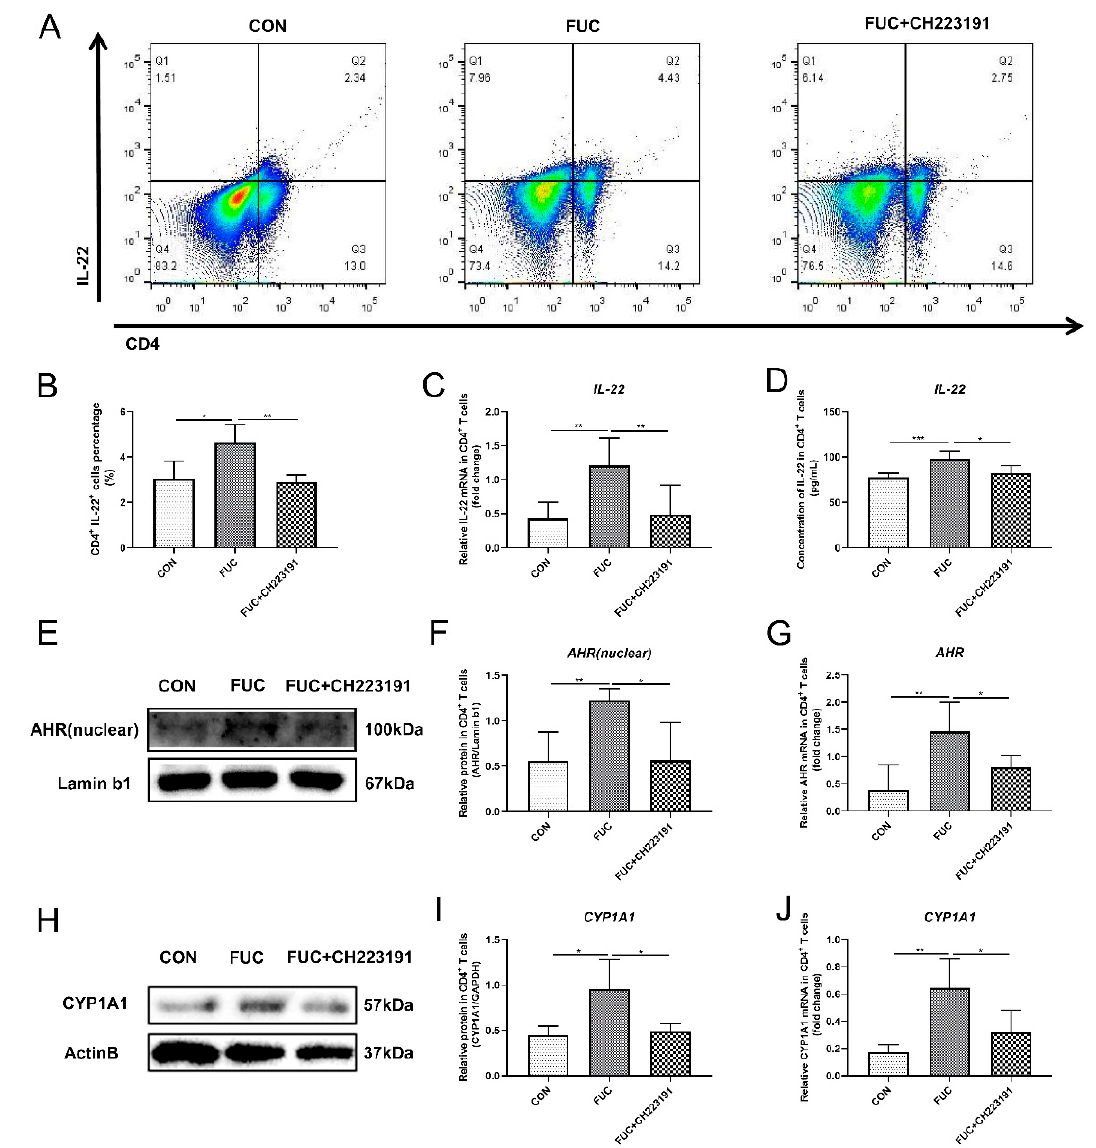
Figure 4. Increased IL-22 secretion from CD4 + T lymphocytes through AHR activation after L- fucose treatment. ( A ) Representative flow cytometric profiles of IL-22 secreting CD4 + cells. ( B ) Per- centage of IL-22 + cells in CD4 + T cells. ( C ) qRT-PCR analysis of IL-22 in CD4 + T cells. ( D ) ELISA analysis of IL-22 in the culture supernatant of CD4 + T cells. ( E ) Western blotting analysis of AHR protein in CD4 + T-cell cell nuclei. ( F ) Quantitative analysis of AHR protein in CD4 + T-cell cell nuclei. ( G ) qRT-PCR analysis of AHR in CD4 + T cells. ( H ) Western blotting analysis of CYP1A1 in CD4 + T cells. ( I ) Quantitative analysis of CYP1A1 protein in CD4 + T cells. ( J ) qRT-PCR analysis of CYP1A1